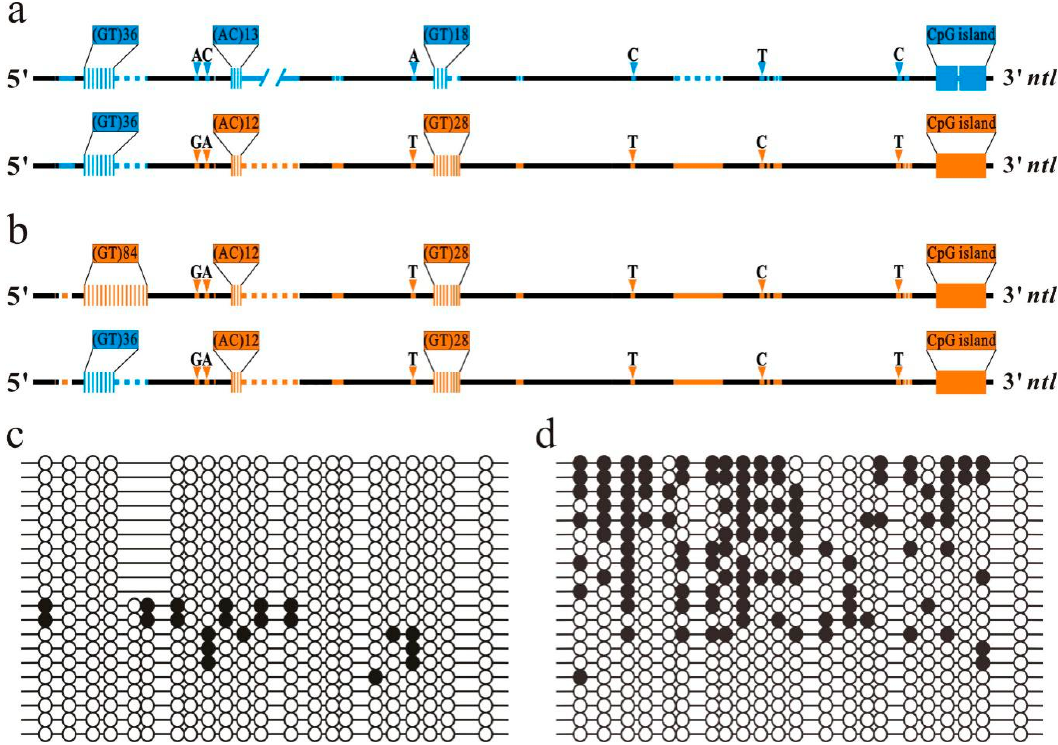
Figure 3. The length of GTM 1 in the upstream region of the ntl promoter has an impact on the methylation of the downstream CpG island. ( a ) The wild type Japanese GF ntl allele promoter and the recombinant Chinese GF ntl allele promoter in the GHD 1. ( b ) The wild type Chinese GF ntl allele promoter and the recombinant Chinese GF ntl allele promoter in the GHD 2. The black represents the conserved sequence regions. Orange and blue symbols represent the Chinese GF and Japanese GF genetic markers as indicated in Figure 2. ( c ) and ( d ) Bisulfite sequencing results of the ntl promoter CpG island in the eggs of the GHD 1 and 2, respectively. The methylated and unmethylated CpG sites are represented by filled circles and open circles, respectively. Each line represents an examined clone. The Chinese and Japanese GF-derived ntl CpG island clones in GHD 1 can be distinguished with the insertion / deletion genetic